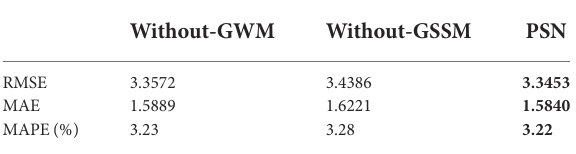
TABLE 7 PEMS08-30 min.